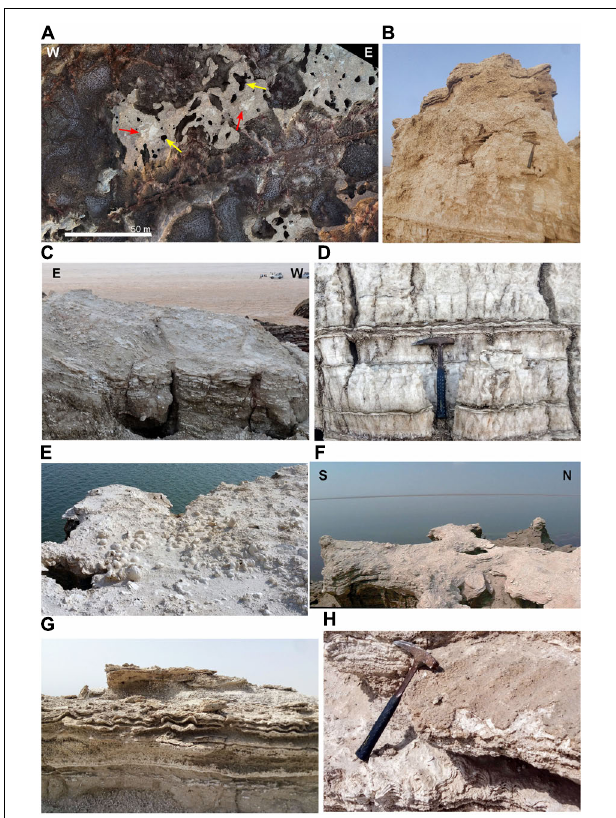
FIGURE 11 | Anhydrite-gypsum units in Dallol and Afrera Formation. Detail of the anhydrite-gypsum unit in the Dallol dome (A–D) compared with the lacustrine Afrera Formation (E–H) . (A) Aerial view of the anhydrite-gypsum unit brecciated (grayish) around sink-holes (yellow arrows) and remains of almost intact thin bedded parts (red arrows) in the inner non-collapsed areas, over the Salt Canyons west of Dallol dome. White bar 50 m long. (B) Laminated anhydrite-gypsum unit atop of the halite bedded sequence while brecciated in the infilled dissolution cavities. (C) Detail of incipient breccia of thin-bedded anhydrite-gypsum levels overlaying halite beds south of Dallol dome. (D) Symmetrical wave ripples in anhydrite levels inside the top of the halite bedded sequence (same location as C ). (E) Anhydrite-gypsum stromatolite beds atop of the Assale islands presumably concordant with the Afrera Formation. (F) Transition from thin bedded to brecciated anhydrite-gypsum stromatolite unit in a landslide/collapsed block in the Assale islands cliffs (location some meters below E ). (G,H) Stromatolites and symmetrical ripples in the Afrera lacustrine formation, north of Bakili